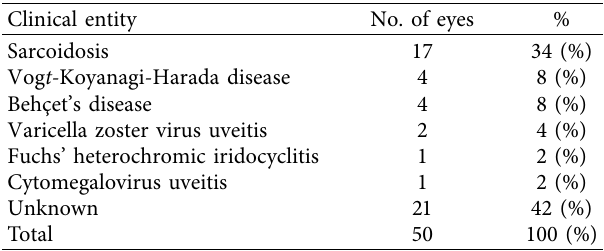
Table 2: Uveitis phenotypic